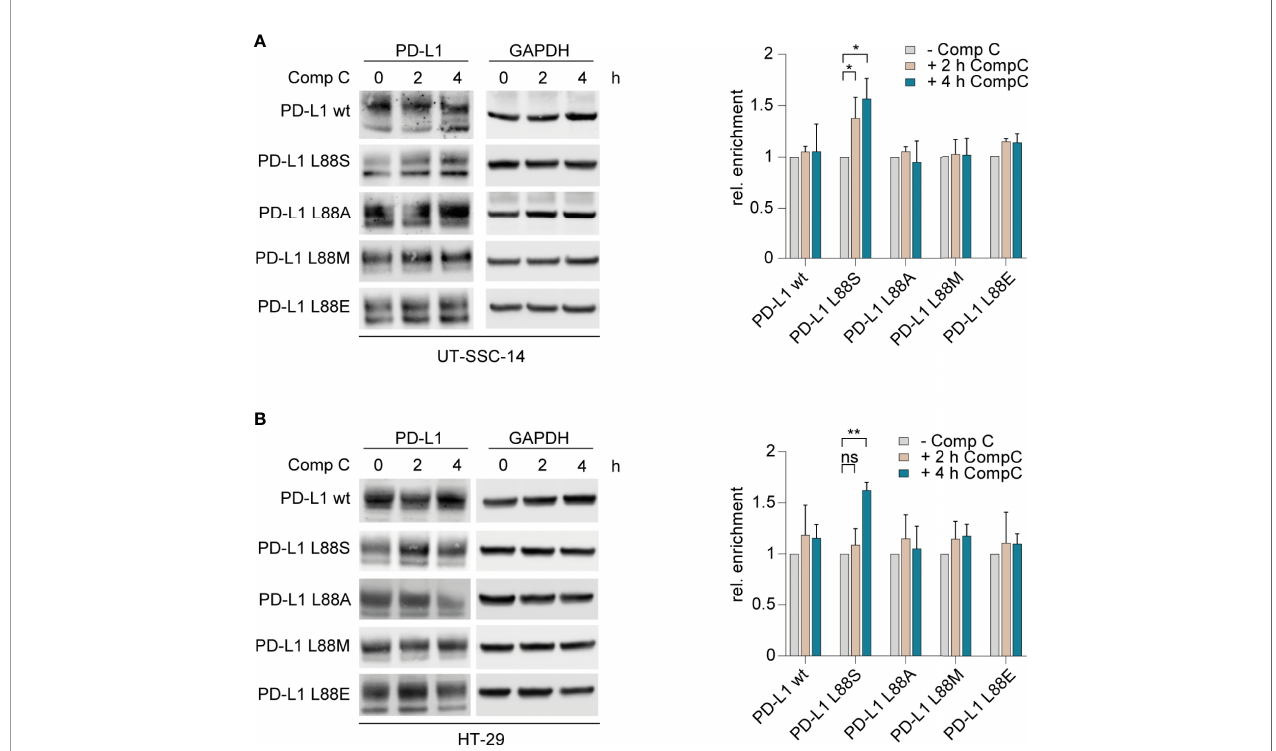
FIGURE 3 | Inhibition of AMPK and examination of its effect on different PD-L1 variants. (A) UT-SCC-14 or (B) HT-29 cells overexpressing fi ve different PD-L1 variants were treated with compound C (CompC) to inhibit AMPK, and cell lysates were analyzed by Western blotting ( n = 3 – 4) before and after 2 and 4 h of treatment. Band intensities of at least two independent experiments were quanti fi ed using ImageJ, and enrichment of PD-L1 was calculated relative to untreated controls after normalization to GAPDH (24). Data are presented as mean ± SD. Statistics: two-sided unpaired t -test. Asterisks indicate p -value range (* p < 0.05; ** p < 0.01; *** p < 0.001; **** p < 0.0001; ns >